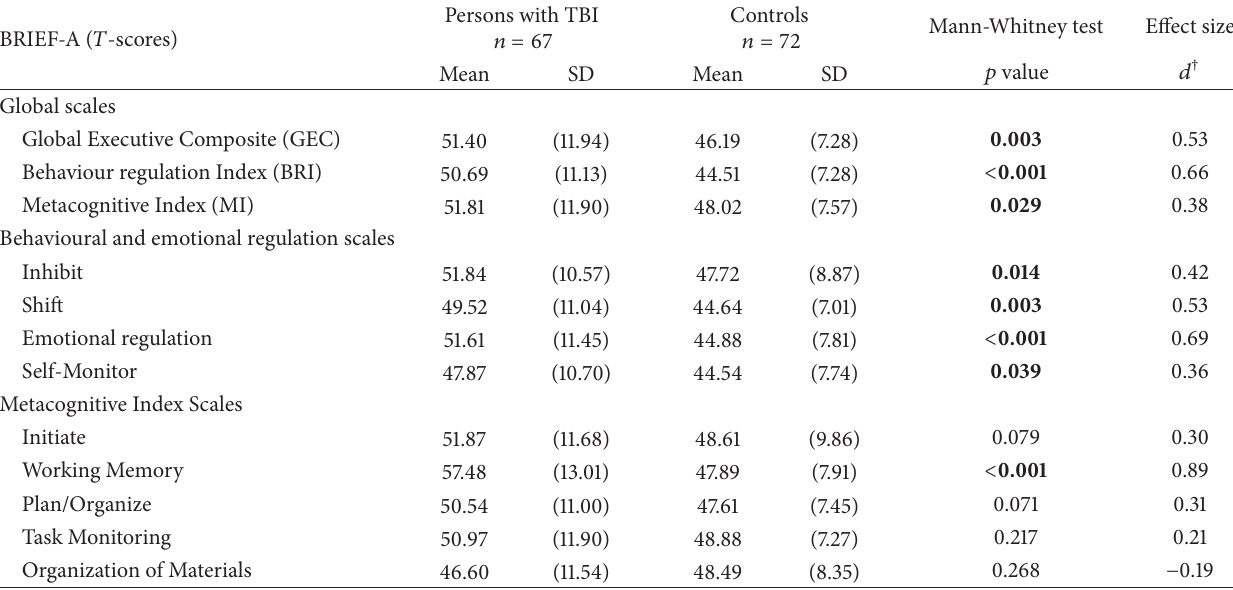
Higher 𝑇 -scores indicate more problems. ∗ Central tendency and variance given as mean and SD. † Cohen’s 𝑑